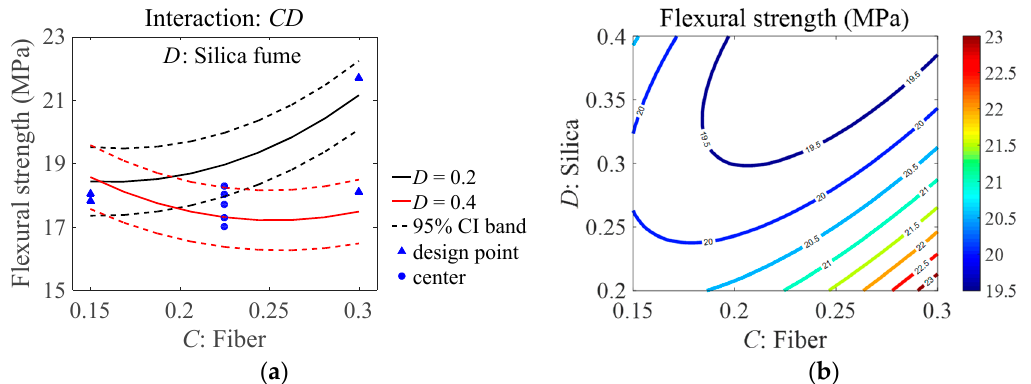
Figure 5. Influence of basalt fiber content ( C ) and silica fume / cement ratio ( D ) on flexural strength. ( a ) Interaction of C and D and ( b ) contour plot of CD on flexural strength.